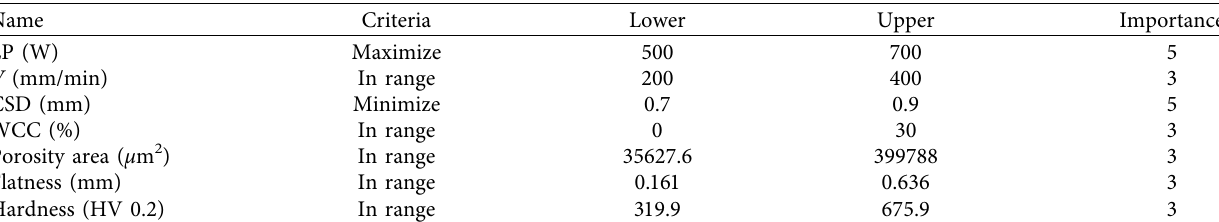
Figure 13: Influence of the interaction between laser power and WC content on the hardness of the cladding layer: (a) contour map; (b) three-dimensional response curve. Table 8: Optimization objectives and scheme.